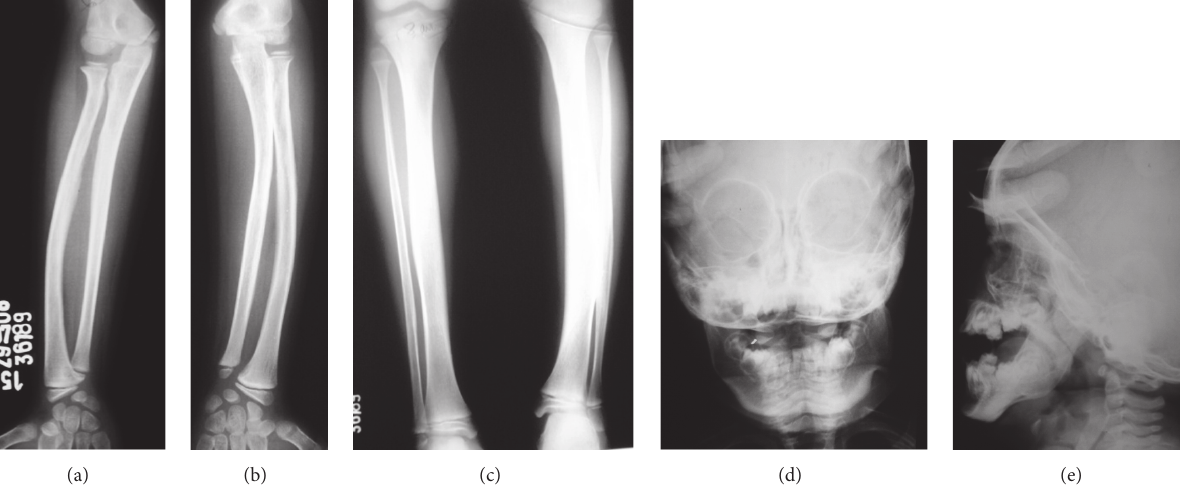
Figure 4: Radiographs showing spontaneous resolution. ((a) and (b)) Radiograph findings of right and left forearms were normal in follow- up examination at eight years of age. (c) The roentgenographic findings of tibias and left fibula were normal in follow-up examination at eight years of age. ((d) and (e)) Swelling of mandible had diminished and disappeared completely at 1 + 2 years of age (frontal and lateral